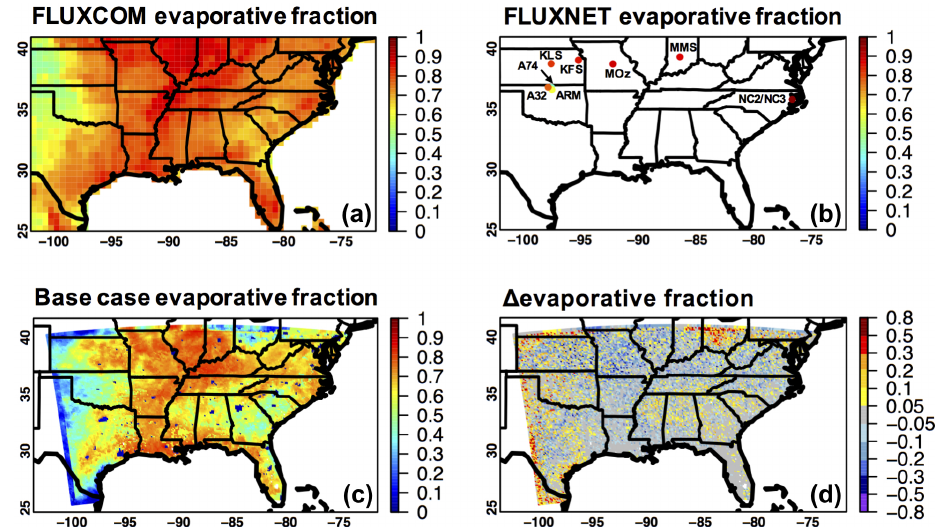
Figure 6. Period-mean (16–28 August 2016) daily evaporative fraction, defined as daily latent heat / (daily latent heat + daily sensible heat), from (a) a FLUXCOM product; (b) selected FLUXNET sites; and (c) the WRF-Chem base case. Panel (d) shows the impact of the SMAP DA on WRF-Chem evaporative fraction. Additional evaluation results for latent and sensible heat fluxes at the focused FLUXNET sites are presented in Fig. S3. Table 2. The SMAP DA impacts on modeled surface meteorological and O 3 fields, as well as their agreement with observations. Variable analyzed Assim–base case, RMSE, base case, (cid:49) RMSE, Percentage of the model grids domain mean ± domain mean ± Assim–base case, with available observations standard deviation, standard deviation domain mean ± in which the SMAP data for all overland grids standard deviation assimilation improved the model performance Daytime 2m air temperature 0 . 099 ± 0 . 373K 2 . 177 ± 0 . 718K ∼ 0 ± 0 . 165K 47.2% Daytime 2m relative humidity − 0 . 573 ± 3 . 225% 12 . 633 ± 4 . 188% − 0 . 024 ± 1 . 765% 51.3% Daytime 10m wind speed 0 . 001 ± 0 . 129ms −